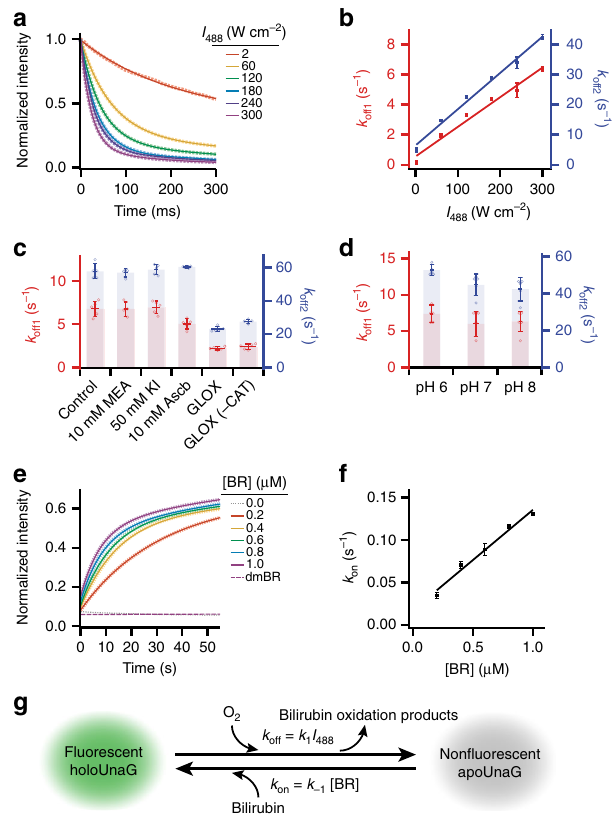
Fig. 2 Kinetic study of the photo-switching process. a Time-dependent fl uorescence decay of holoUnaG under different irradiation intensity of the 488-nm laser source. The fl uorescence intensities were recorded with 5-ms time resolution. Dotted lines are the averaged low decay curves, and solid lines indicate bi-exponential fi ts to the decay curves. b Off-switching rates ( k off1 and k off2 ) of holoUnaG under various laser intensities obtained from a . Linear fi ts (solid lines) gave fi rst-order kinetic rate constants for the bleaching reactions. c Off-switching rates at 300W cm − 2 of intensity in different imaging buffer supplements such as β -mercaptoethylamine (MEA), potassium iodide (KI) and ascorbic acid (Ascb). Only the oxygen scavenging systems based on glucose oxidase and catalase (GLOX and CAT) signi fi cantly slowed down the fl uorescence decay, indicating that the major photo-degradation pathway of holoUnaG is the photo-oxidation. d Off- switching rates at 300 W cm − 2 of intensity in different pH conditions. Little notable differences were observed. e Time-dependent fl uorescence recovery of bleached holoUnaG in various concentration of external BR from 0.0 to 1.0 μ M (dotted lines) and in photo-damaged BR (dmBR, purple dashed line). Solid lines indicate the fi tting results using Supplementary Equation 14. The fl uorescence intensities were recorded with 1-s time resolution. f On-switching rates ( k on ) of holoUnaG in different BR concentrations obtained from c , displayed with a linear fi t. g Proposed two- state fl uorescence switching model of holoUnaG. Light-induced oxidation of BR inside of holoUnaG by dissolved oxygen turns off the fl uorescence, whereas the reverse reaction is purely affected by freely diffusing BR in solution. Thus, the switching rates in both directions can be controlled individually by either the light intensity or the BR concentration. Intensities in a and e were normalized by the initial value. Error bars: standard deviations ( n = 5, from independent bulk measurements of pulled-down samples).